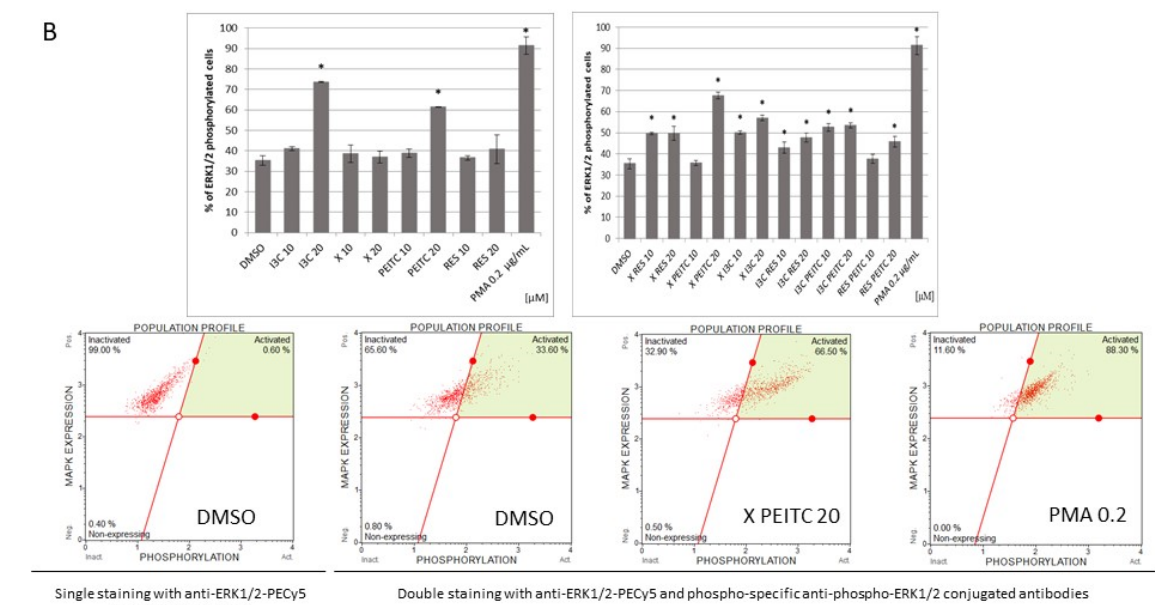
Figure 8. The impact of X, PEITC, RES, I3C, and their mixtures on GSK-3 β expression and phosphorylation and ERK1/2 phosphorylation in HepG2 cells. Panel ( A ) GSK-3 β expression was estimated as mRNA level comparing to control cells (a fold of control). Exemplary immunoblots are presented for GSK-3 β and p-GSK-3 β protein level. Western blot results are estimated as protein levels comparing to vehicle control (a fold of control). Panel ( B ) The impact of X, PEITC, RES, I3C, and their equimolar mixtures on ERK1/2 phosphorylation in HepG2 cells. The phosphorylation was measured by the flow cytometric analysis after double staining of cells with anti-ERK1/2-PECy5 and phospho-specific anti-phospho-ERK1/2 conjugated antibodies. PMA (para-methoxyamphetamine) was used as a positive control of ERK1/2 phosphorylation. The values are shown as the mean ± SEM calculated from three independent experiments (a fold of control) and determined by one-way ANOVA, post-hoc Dunnet test (* p < 0.05). Lane 1, cells treated with DMSO; lane 2, I3C 5 µ M; lane 3, I3C 10 µ M;